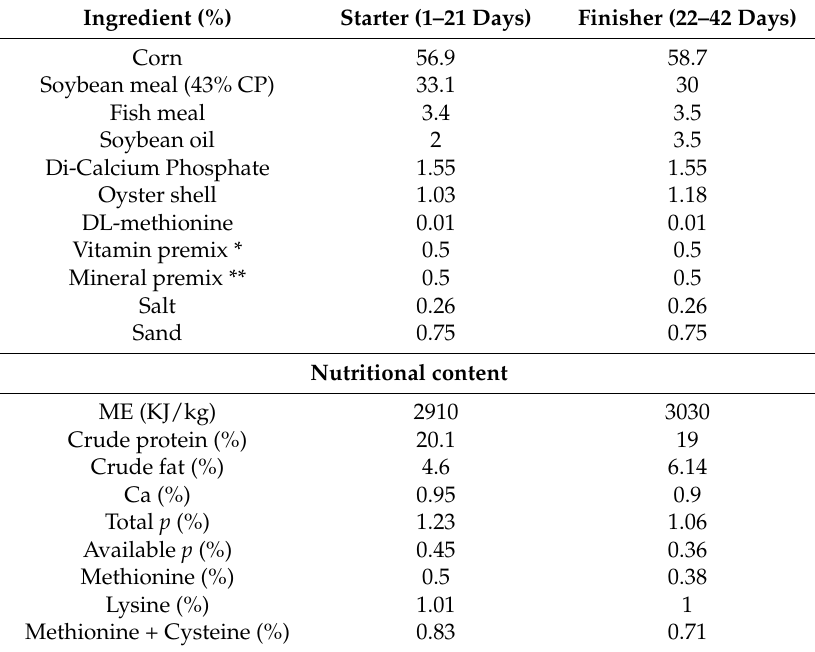
Table 1. The ingredients and nutritive contents of the